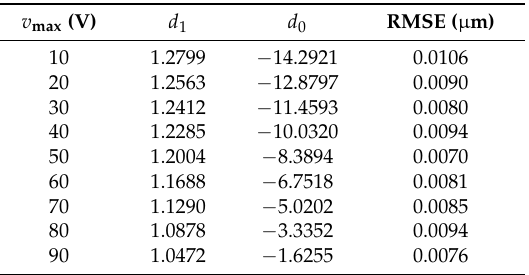
Table 1. The identification results of Equation (1) ( v 0 max = 100 V).